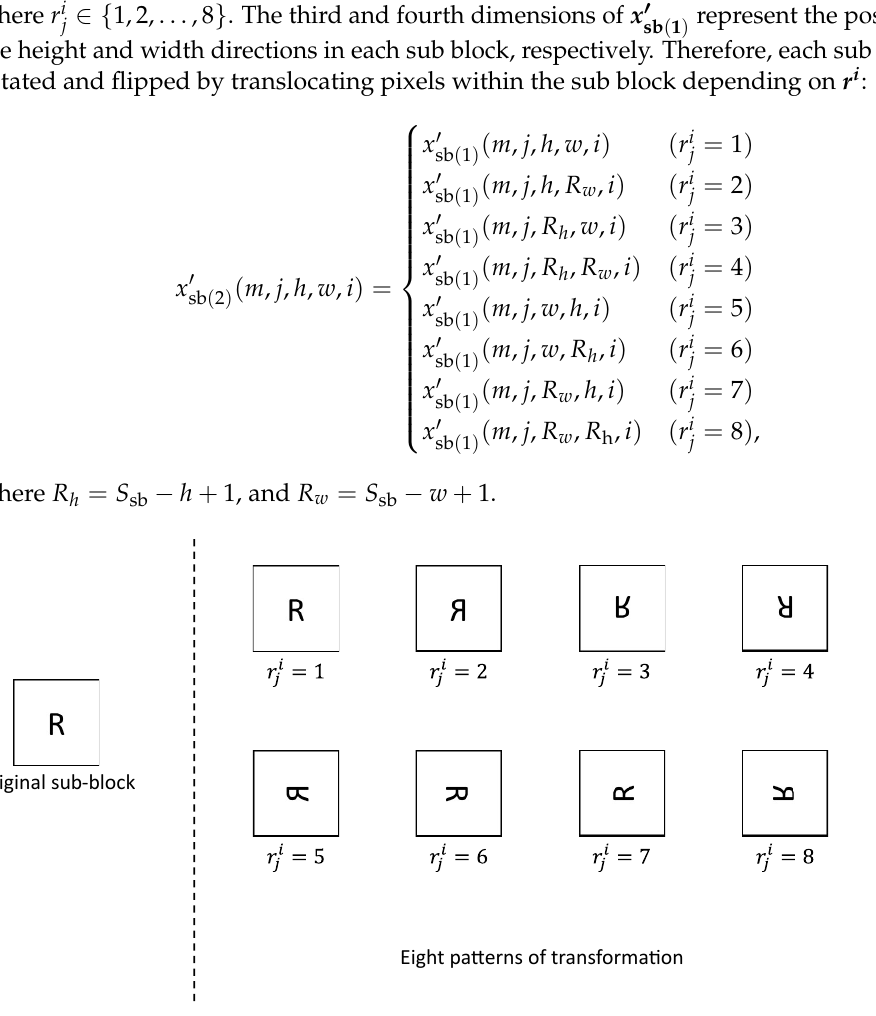
Figure 6. Transformation patterns in block rotation and block